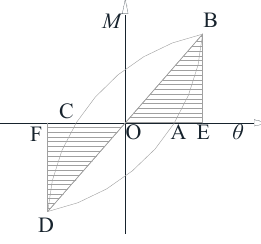
Figure 21. Definition of a hysteresis loop.